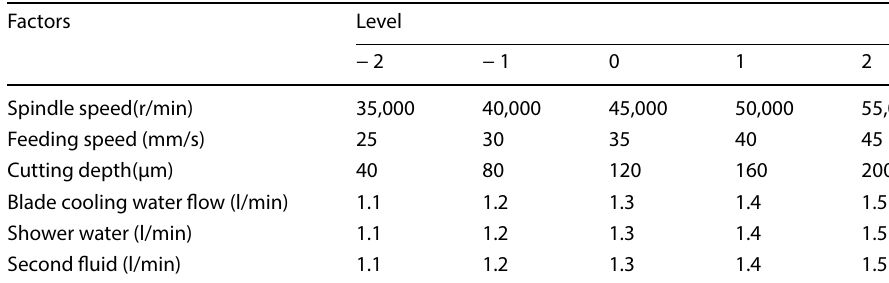
Table 2 Table of factor levels of cutting parameters